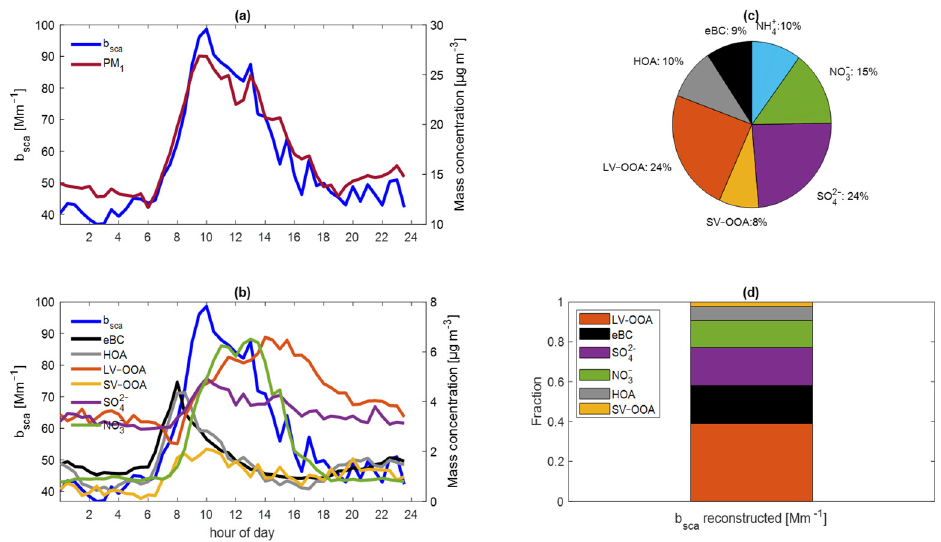
Figure 5. The average diurnal profile of ( a ) the scattering coefficient and PM 1 and ( b ) eBC, HOA, LV–OOA, SV–OOA, SO 42 − , and NO 3 − . ( c ) Average percent composition of PM 1 . ( d ) Contribution of eBC, HOA, LV–OOA, SV–OOA, SO 42 − , and NO 3 − to the light scattering at 532 nm. The MLR considered all the species in PM 1 . There was not enough ammonium to MSE 532 . The MSE 532 of NO 3 − and SO 42 − were 5.83 and 2.80 m 2 g − 1 , respectively. Although the